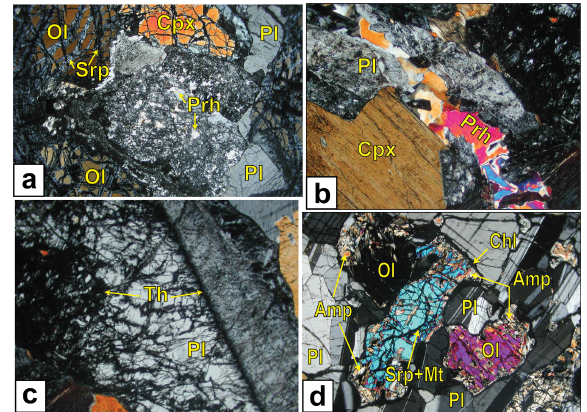
Figure 6. Cross-polarized light images of minerals from Hole J, Site U1415. (a) A sample of troctolite from Unit III (J19R1_39- 45), showing prehnite (Prh) replacing plagioclase (Pl) and serpen- tine (Srp) replacing olivine (Ol), forming a mesh texture in a pla- gioclase + clinopyroxene (Cpx) host. (b) A prehnite vein cutting Pl and Cpx in gabbro from Unit II (J8R3_114-116). (c) Ca-thomsonite (Th, very low birefringence) replacing Pl in gabbro Unit II (J8R3 114–116). (d) The alteration of Ol by amphibole (Amp) and by ser- pentine + magnetite (Mt) and the alteration of Pl + Ol by chlorite (Chl) in sample J7G1